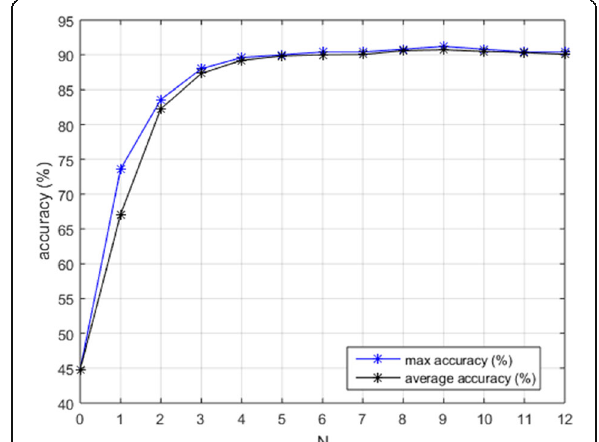
Fig. 5 Maximum obtained accuracy (max accuracy) and average value of the top-10 obtained values for accuracy (average accuracy) for the five-class problem, for N = 0 –